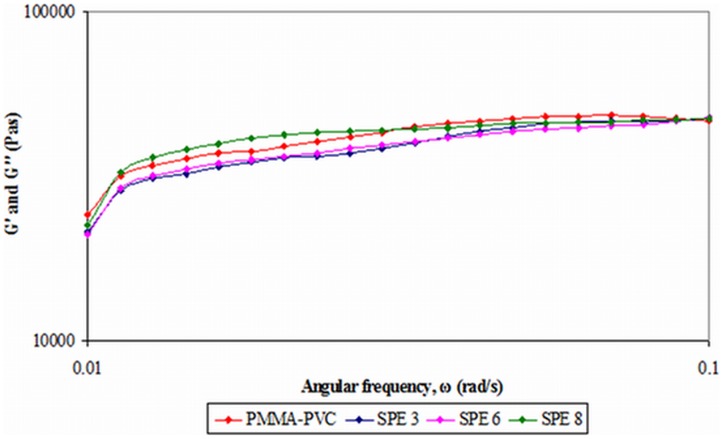
Frequency sweep of second system.